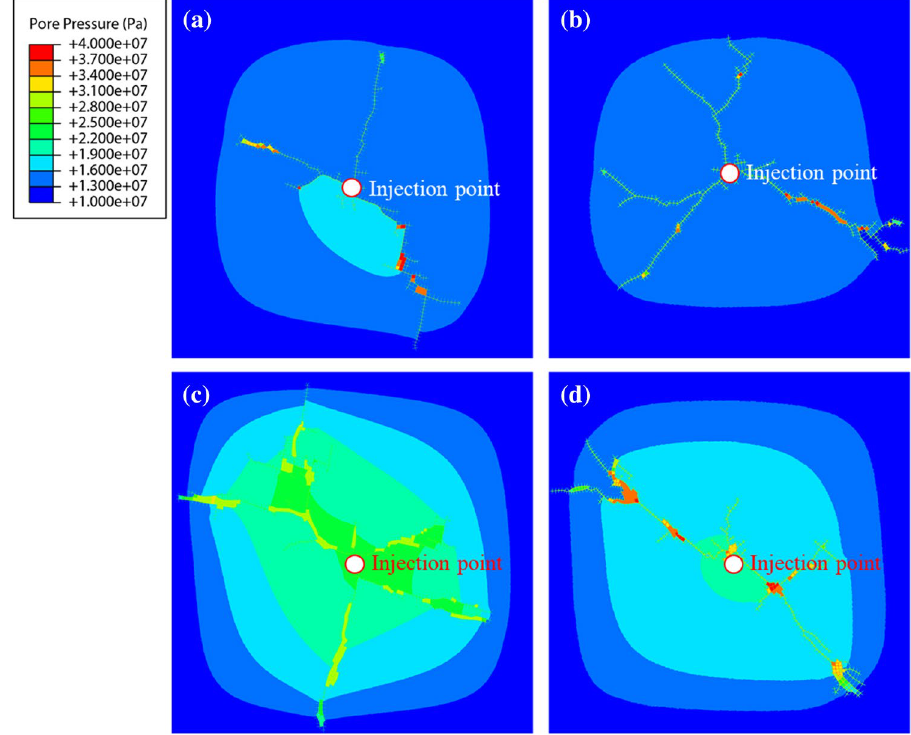
Fig. 6 Pore pressure distribution in formation at end of